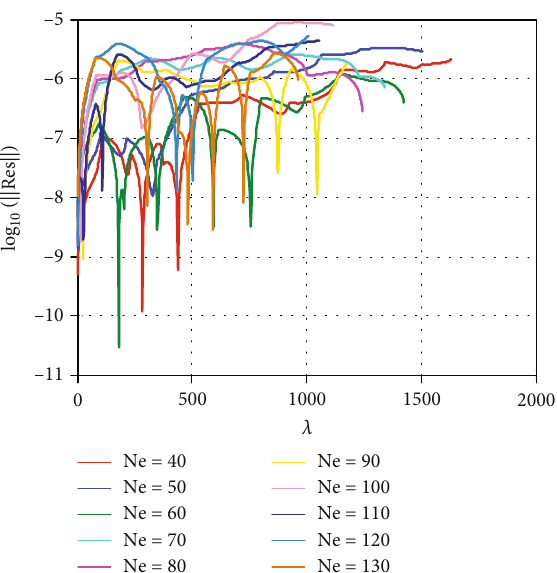
Figure 5: In fl uence of the mesh on the residue vector: evolution of the Euclidian norm of residue vector with respect to the loading parameter for di ff erent